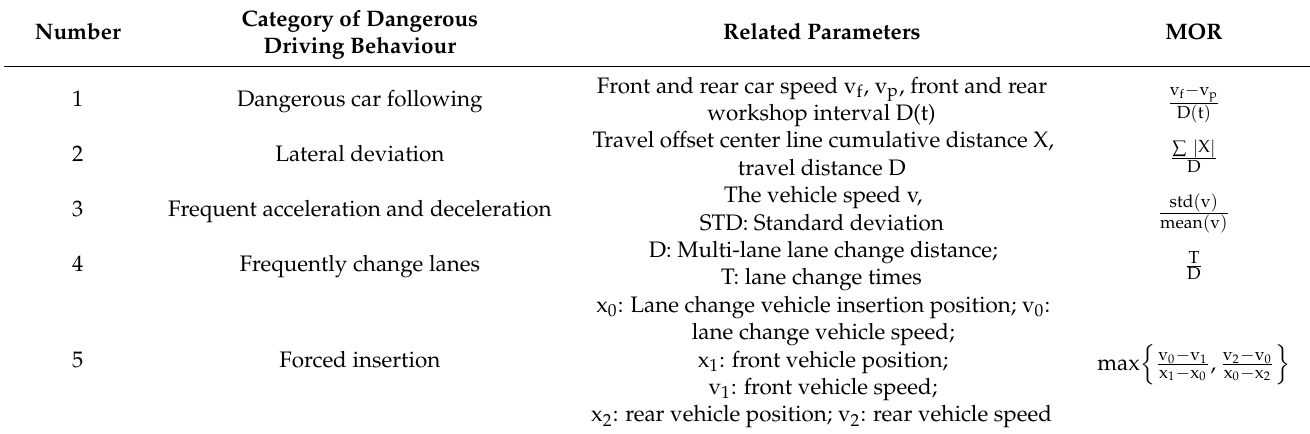
Table 1. Calculation method of MOR on